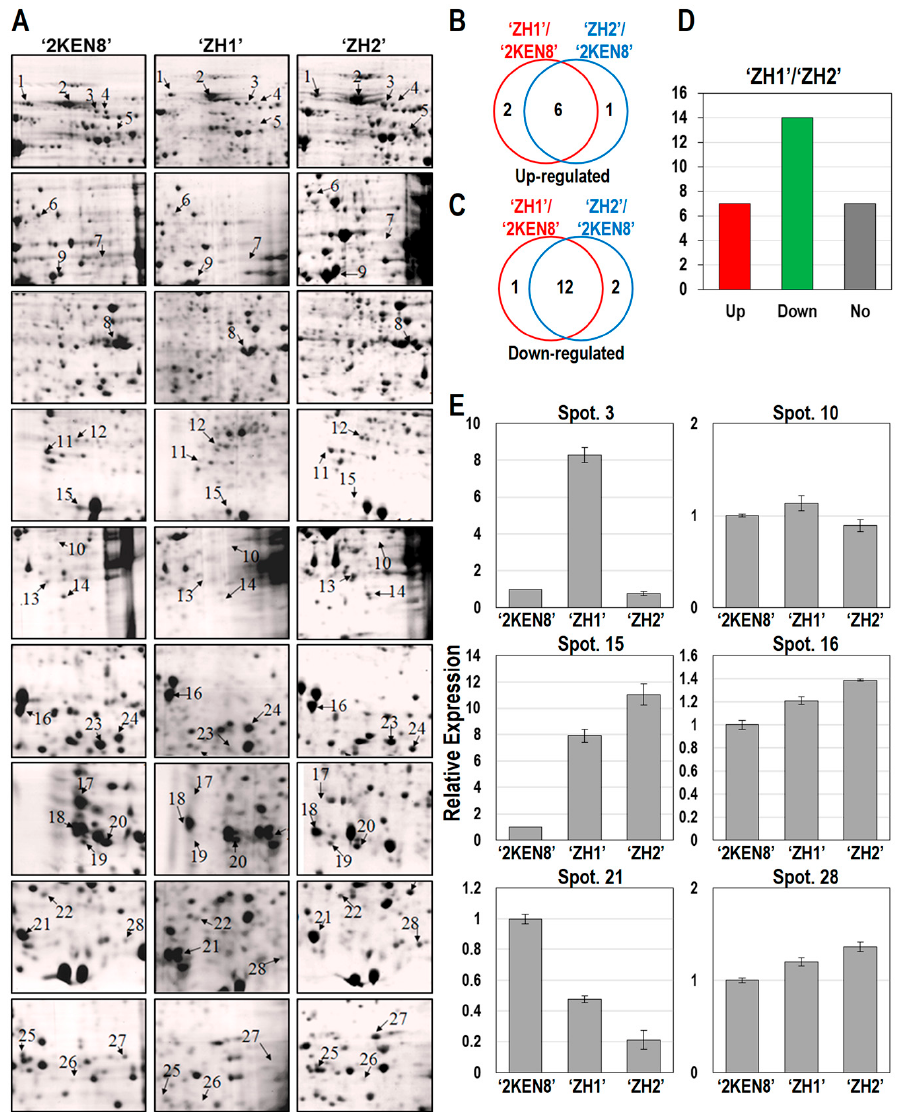
Figure 6. Predicted allergenic proteins in P. deltoides ‘ZH1’, ‘ZH2’, and ‘2KEN8’ mature pollen. ( A ) The protein abundance of previously predicted 28 allergenic proteins [22] in three P. deltoides cultivars ‘ZH1’, ‘ZH2’, and ‘2KEN8’ mature pollen; Venn diagram of upregulated ( B ) or downregulated ( C ) proteins in ‘ZH1’ and ‘ZH2’ compared with ‘2KEN8’ from ( A ); ( D ) differentially expressed proteins among 28 predicted allergenic proteins between ‘ZH1’ and ‘ZH2’; ( E ) expression analysis of six selected allergen related genes in the three cultivars using qRT-PCR. Table 2. Differential expression of 28 candidate allergenic proteins.